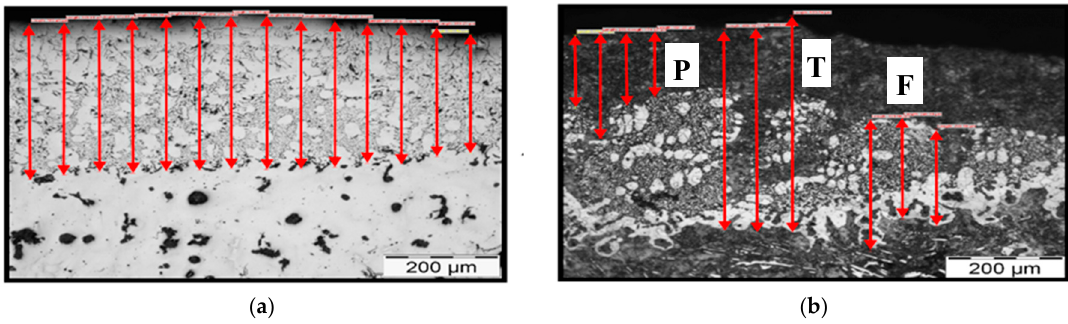
Figure 3. Measurement of surface layer thickness in un-etched ( a ) and etched ( b ) samples (P—pearlitic rim; T—total rim; F—ferritic rim).